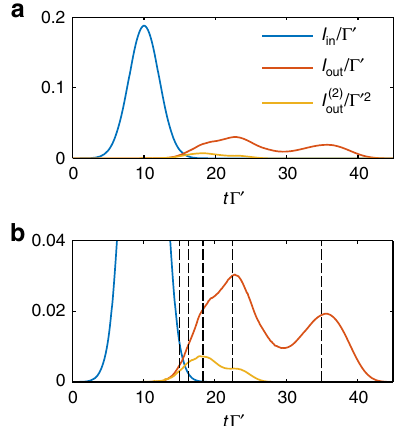
Fig. 4 VIT output fi eld. a Pulse propagation in a VIT medium with optical depth OD = 400, simulated using N = 100 atoms coupled to a 1D- waveguide, and averaged over 20000 quantum trajectories. Input of a coherent pulse with | α | 2 = 1 (blue) results in an output intensity I out ( t ) (red) with two main peaks. Also plotted is the second-order correlation function I ð 2 Þ t ; t Þ (yellow). b Zoom of the plot above, with dashed lines showing the out ð expected positions of pulses delayed by τ n , for n = 1, … , 5. Simulation parameters are Γ 1 D = 2 Γ ′ , Δ = δ c = 0, g = 4 Γ ′ , κ = 0.03 Γ ′ , σ t = 3/ Γ ′ and t 0 = 10/ Γ ′ . We chose D = 50 and δ t = 0.01/ Γ ′ where convergence